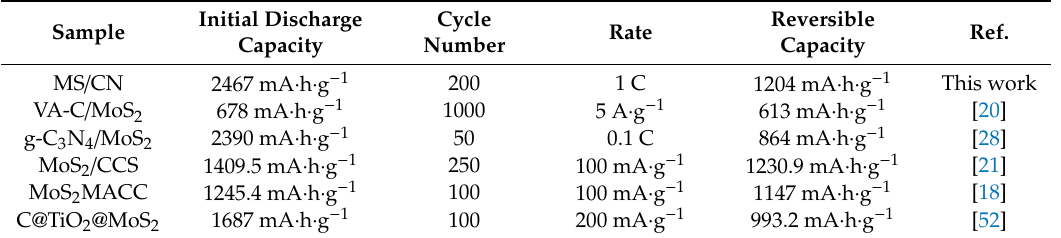
Table 2. Comparison of electrochemical performances of MoS 2 -based anode